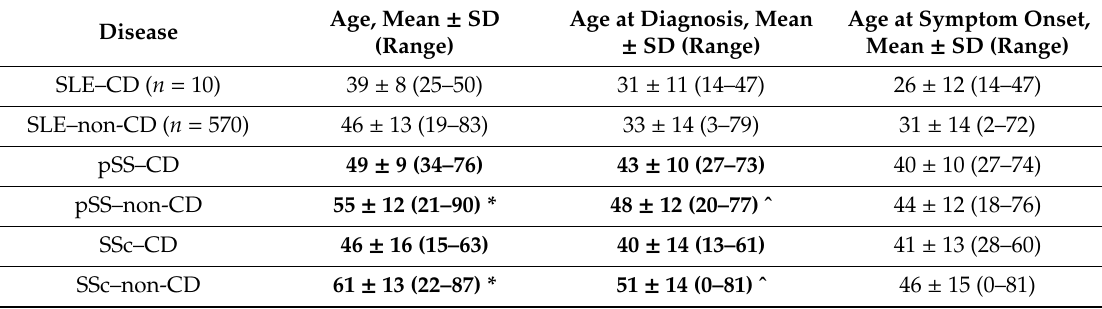
Figure 1. Age at CD diagnosis with respect to age at AD diagnosis. Table 6. Age at diagnosis and age at symptom onset of SLE, pSS and SSc patients with CD in comparison to those without evidence of CD. Age, Mean ± SD Age at Diagnosis, Mean ± Age at Symptom Onset, Disease (Range) SD (Range) Mean ± SD (Range)